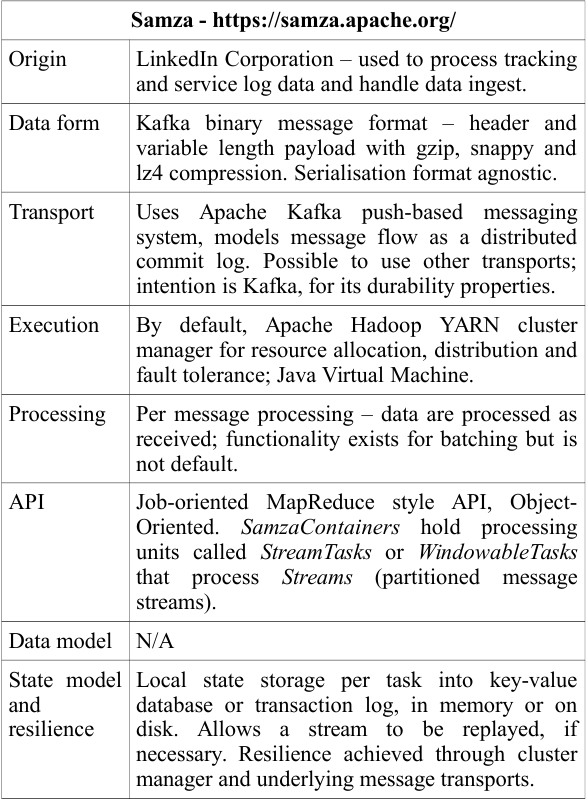
Table 2: Streaming Frameworks – Samza